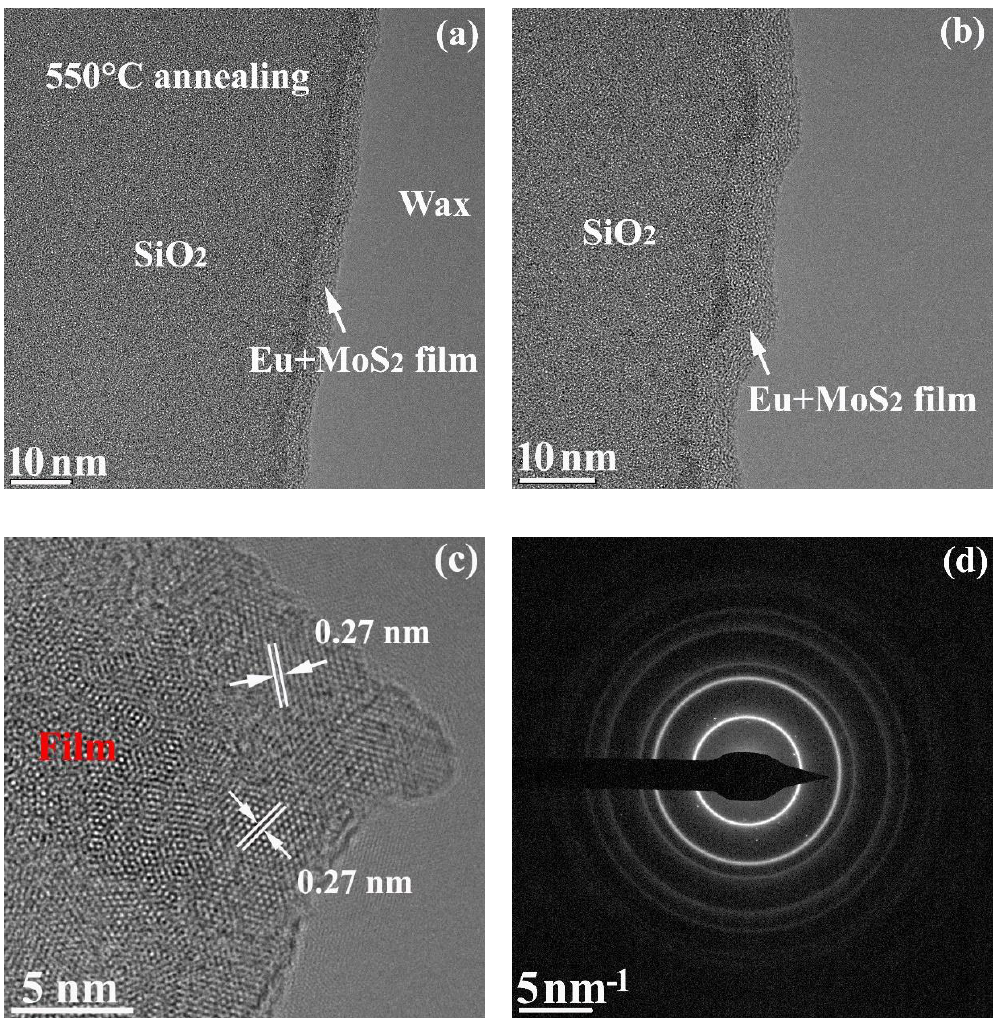
Figure 4. ( a , b ) Cross-sectional views of Eu-doped MoS 2 samples after the 550 ◦ C Ar + 10% H 2 annealing. ( c ) HRTEM image of the MoS 2 sample and ( d ) the sample’s diffraction